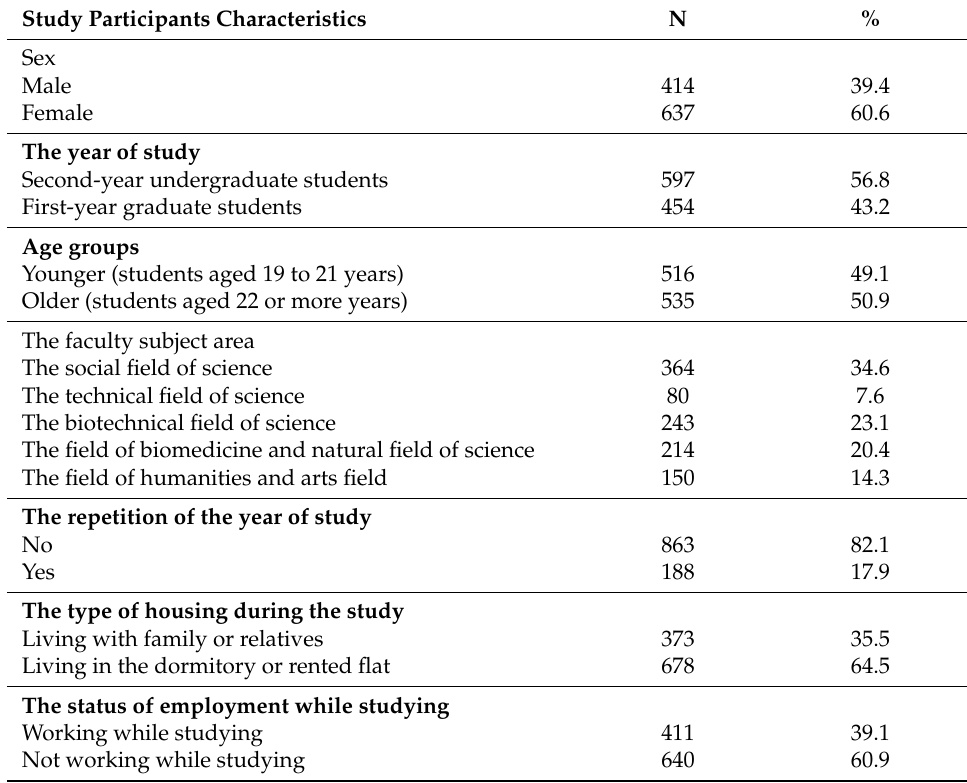
Table 1. Characteristics of all study participants.